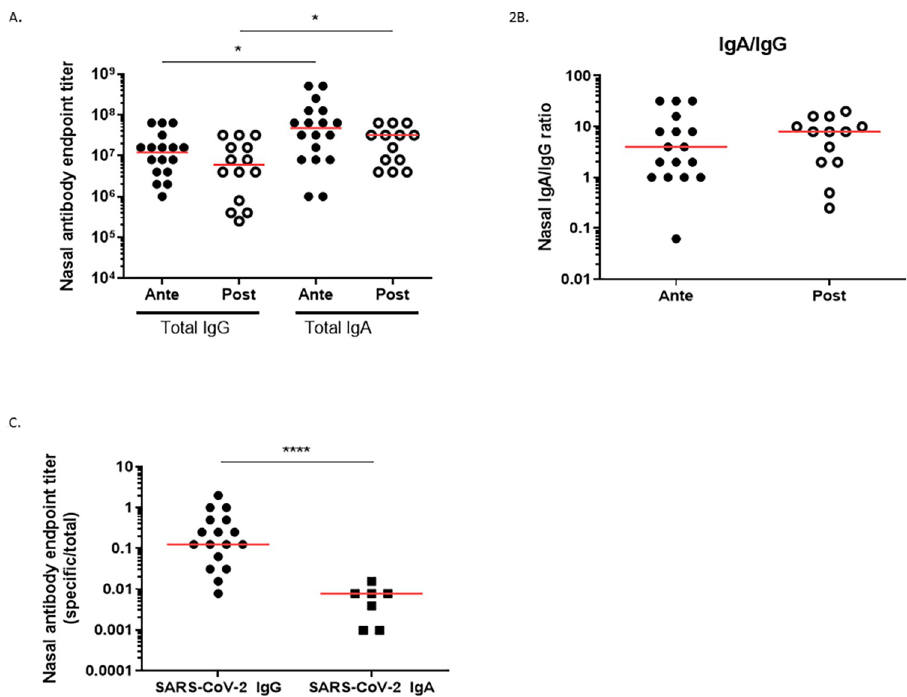
Fig 2. Mucosal humoral immunity in infants. A) IgG and IgA binding titer in infant nose. Horizontal red lines represent median values. B) IgA/IgG endpoint titer in infant nose. Horizontal red lines represent median values. C) Nasal endpoint titers expressed as ratio between anti-spike endpoint titer/Total class endpoint titer. Differences between groups were tested by the 2-tailed Mann Whitney test, with a P � 0.05 being considered significant. * = P � 0.05; ** = P � 0.01; *** = P � 0.001; **** = P �